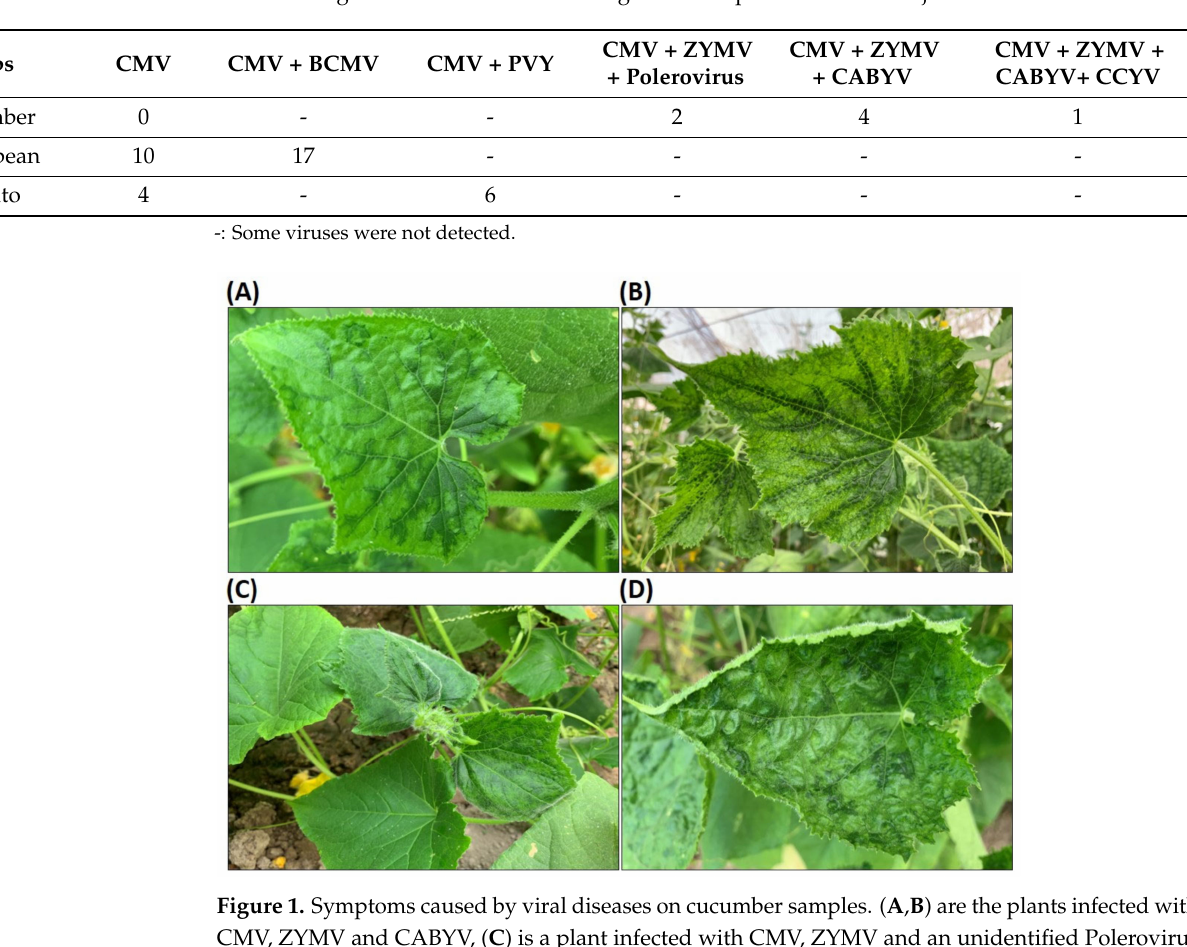
Table 3. Diagnosis of viral diseases in vegetable samples collected in Tajikistan.